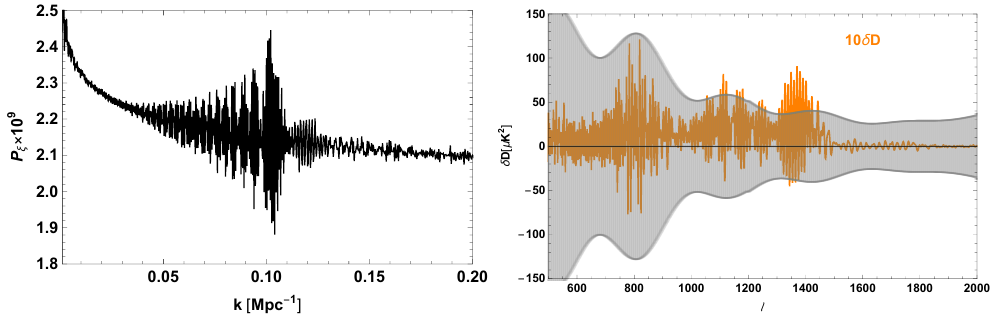
Figure 5 . Left: primordial spectrum resulting from phase transition oscillations (cid:12)xing (cid:3) = 6000 H; M = 1020 H; m (cid:31) = 10 H; m h = 2 H; (cid:21) = 1, adding on top of a smooth spectrum with n s = 0 : 9649. Right: the corrections in the CMB temperature spectrum by subtracting that of the in(cid:13)ation model with n s = 0 : 9649 (right). In plotting, we have multiplied the oscillating correction by a factor of 10. The grey band denotes the unbinned Planck uncertainties, which are (cid:24) 5% when expressed as fractional